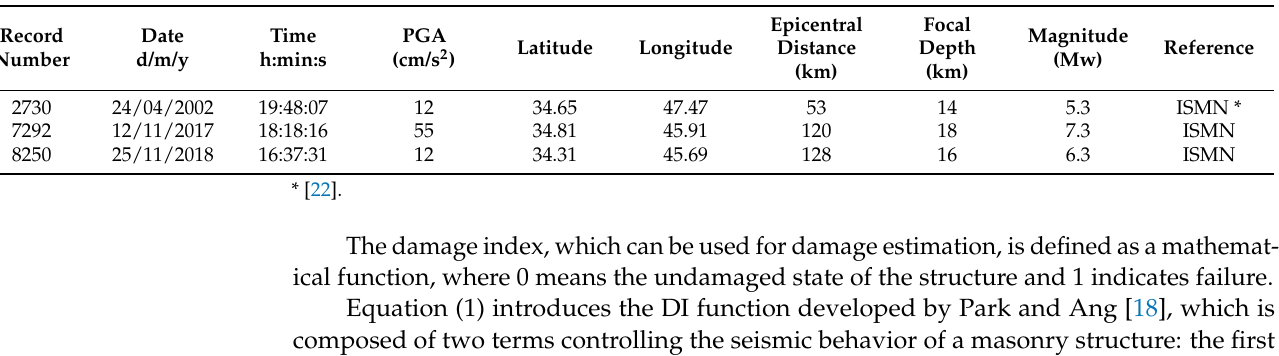
Table 1. Accelerograms used in the analysis.